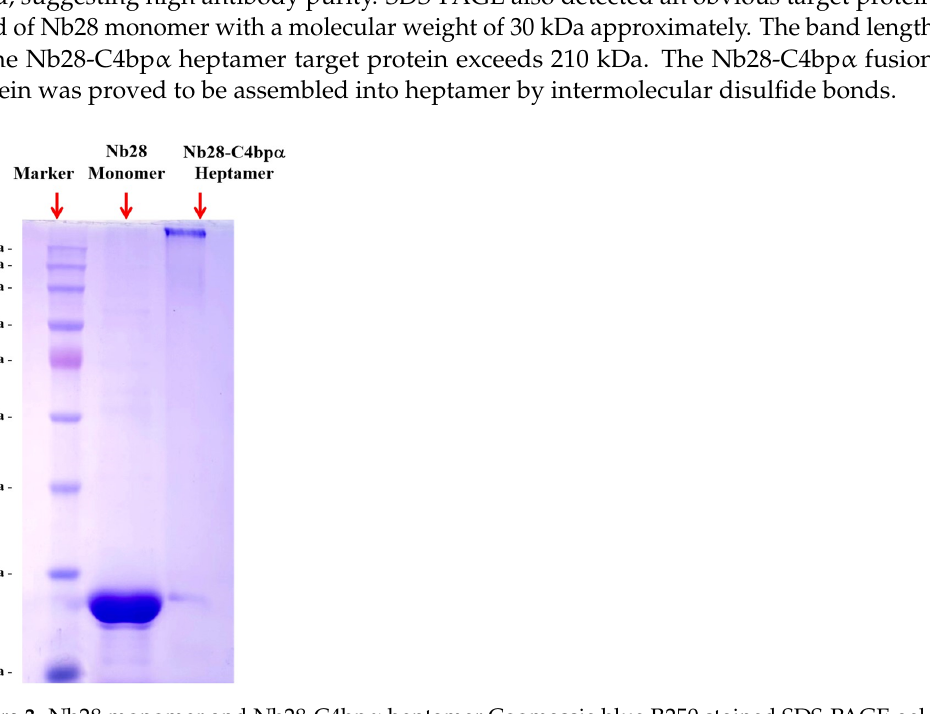
Figure 3. Nb28 monomer and Nb28-C4bp α heptamer Coomassie blue R250 stained SDS-PAGE